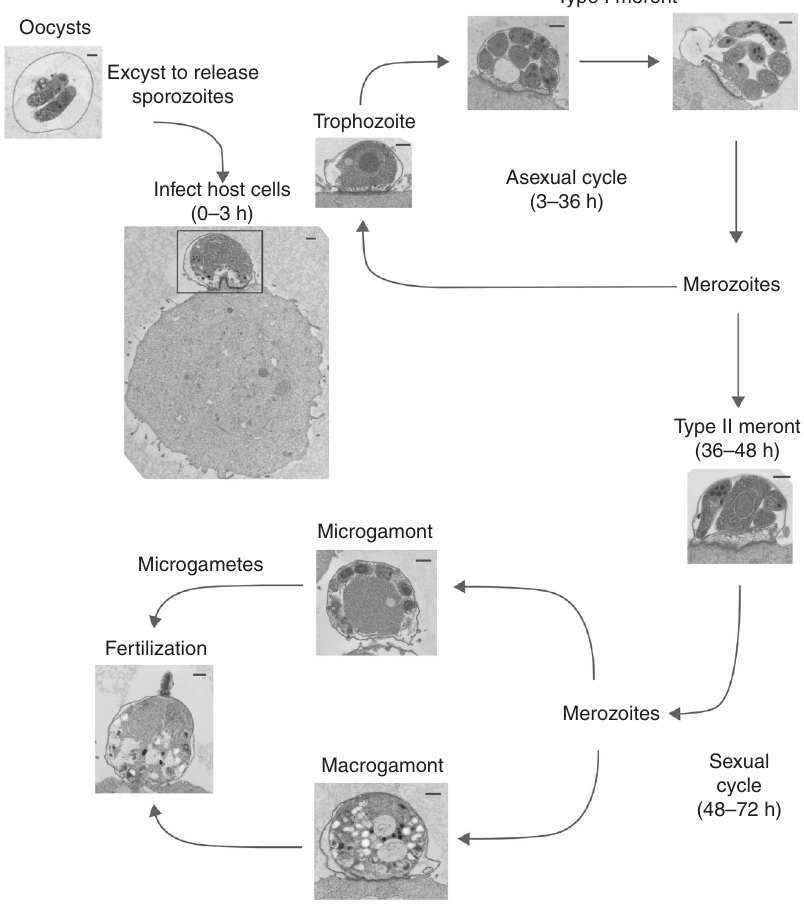
Fig. 1 Transmission electron microscopy images showing C. parvum life cycle stages present in the HCT-8 cell culture system. C. parvum oocysts were induced to excyst and used to infect HCT-8 cell monolayers. Parasite morphology was then analyzed by transmission electron microscopy (TEM) at different time points ranging from 12 to 96 h after infection. The approximate timing of each stage is indicated. Scale bars = 500 nm. Images are representative of two independent